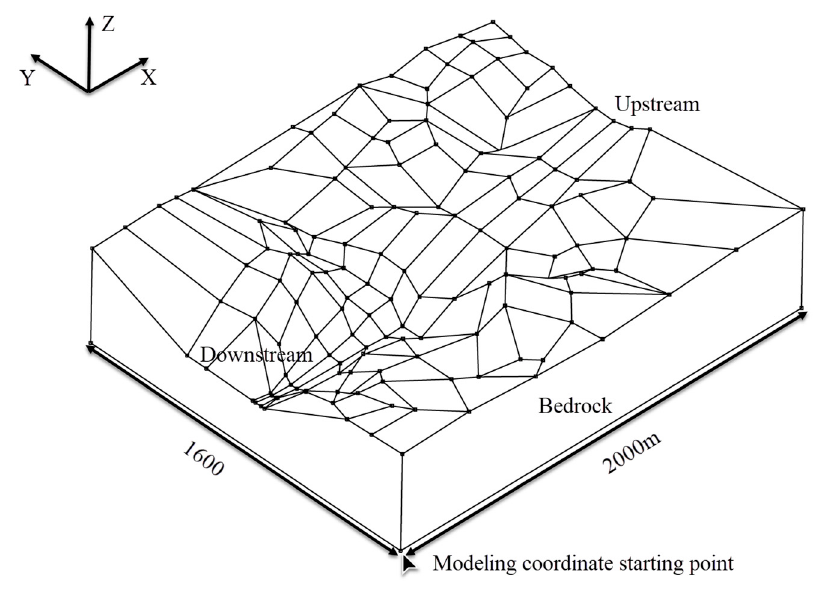
Figure 5. Foundation model.